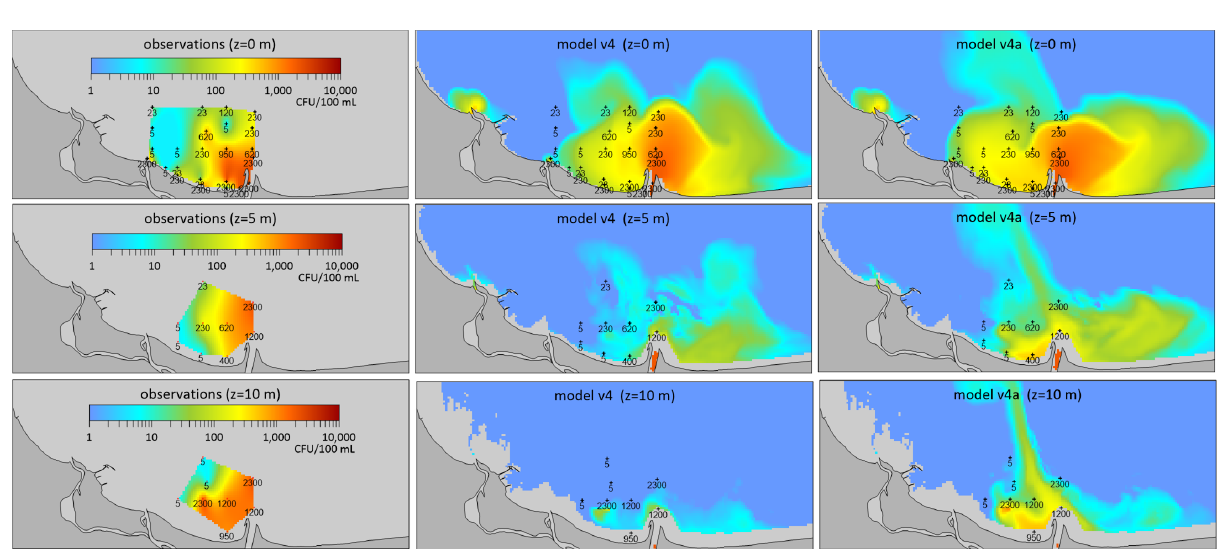
2.2. A Case Study Dated 12 August 2003—Spatial Distribution at Different Depths